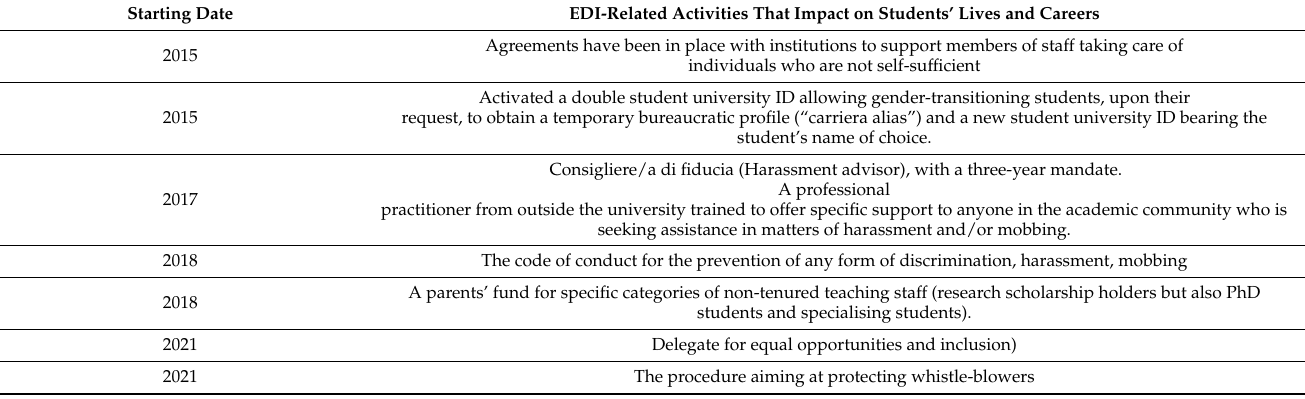
Table 1. EDI-related activities.